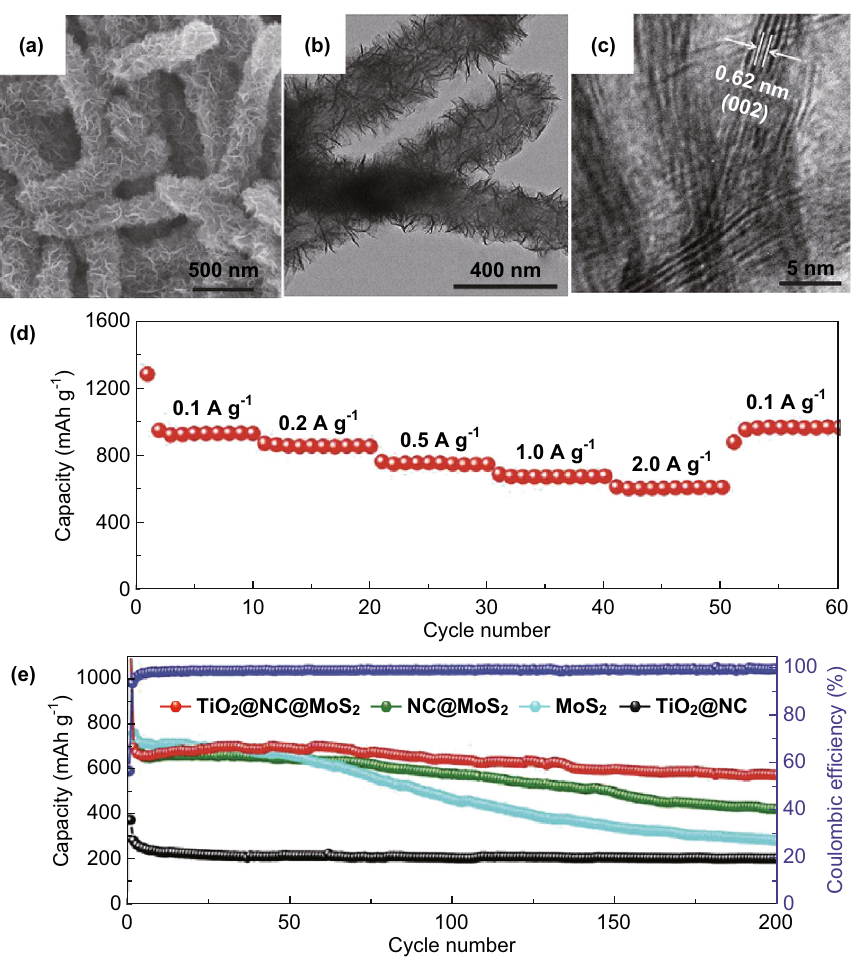
Fig. 7 3D architectures based on 1D TiO 2 nanotubes@carbon layer@2D MoS 2 nanoflakes for LIBs. a SEM and b TEM images of annealed